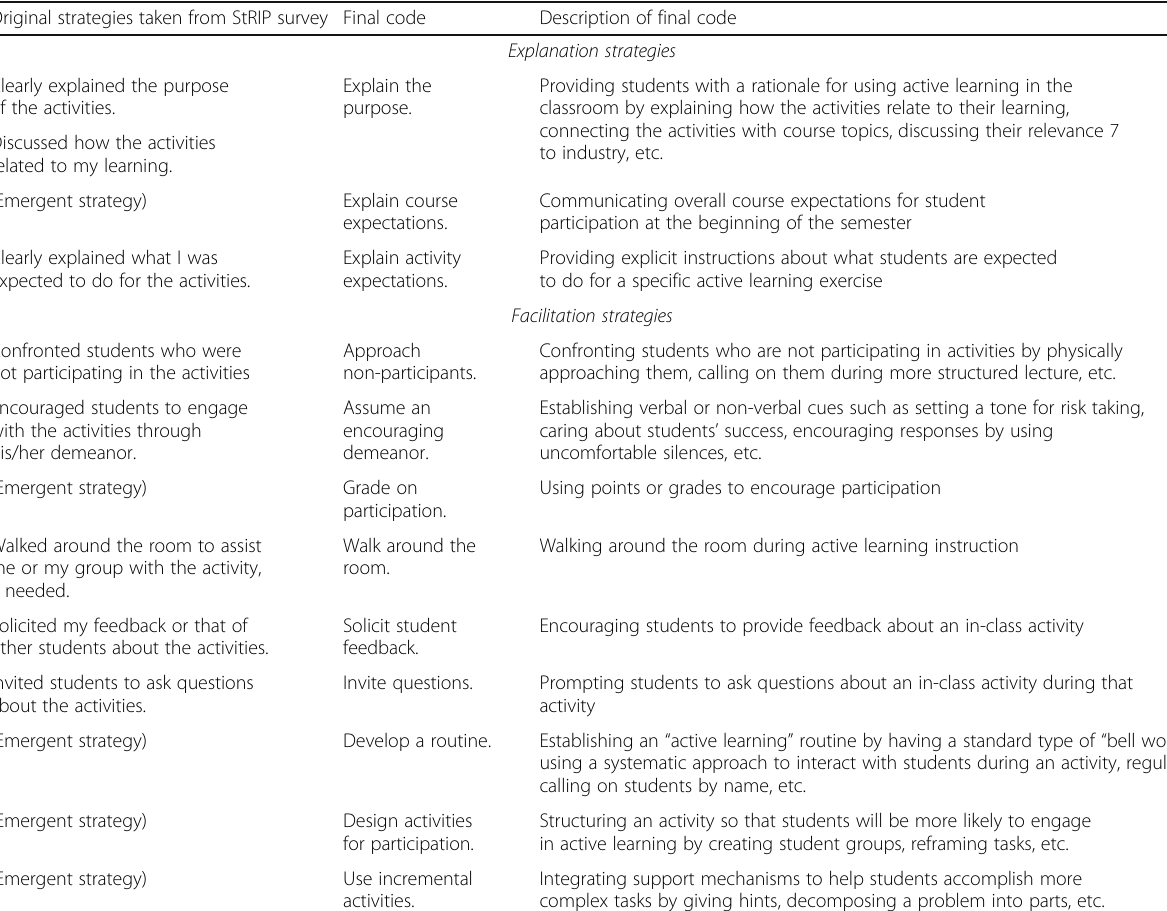
Table 2 Coding scheme with definitions Original strategies taken from StRIP survey Final code Description of final